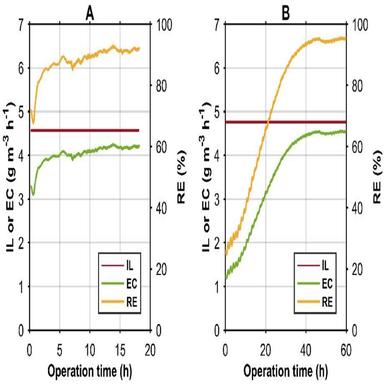
(A) Evolution of IL, EC and RE after addition of nutrients, following a period of 3 weeks of operation without nutrient addition. The IL was 4.58 g m3 h1 and the RE was initially 75%. (B) Evolution of IL, EC and RE after addition of nutrients, following a period of 3 months of operation without nutrient addition. The IL was 4.77 g m3 h1 and the RE was initially 31%.